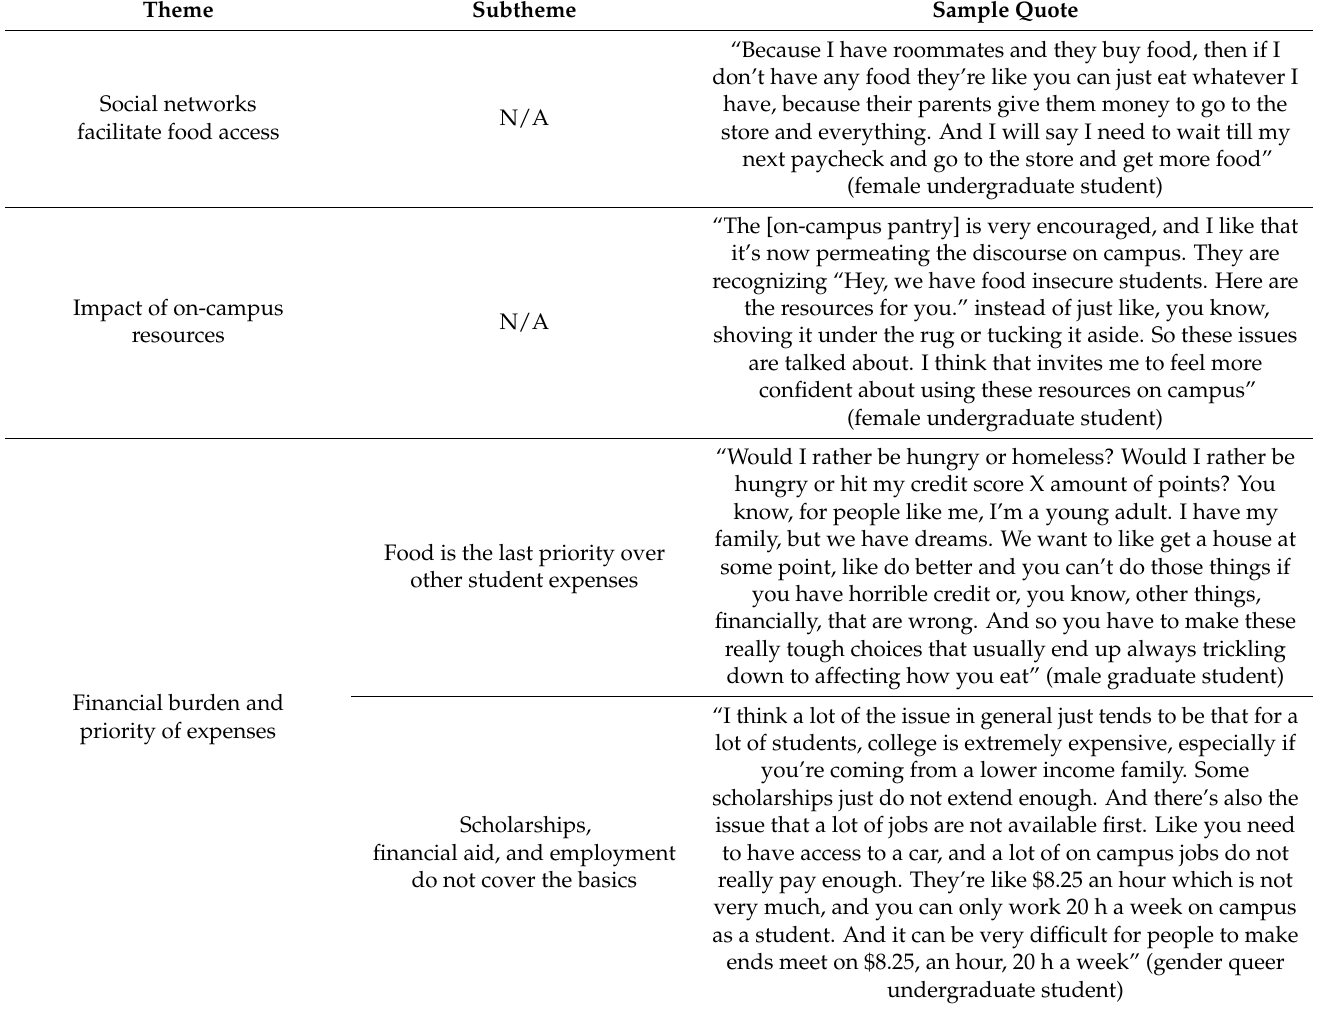
Table 3. Emergent themes and sample quotes related to facilitators and barriers to food